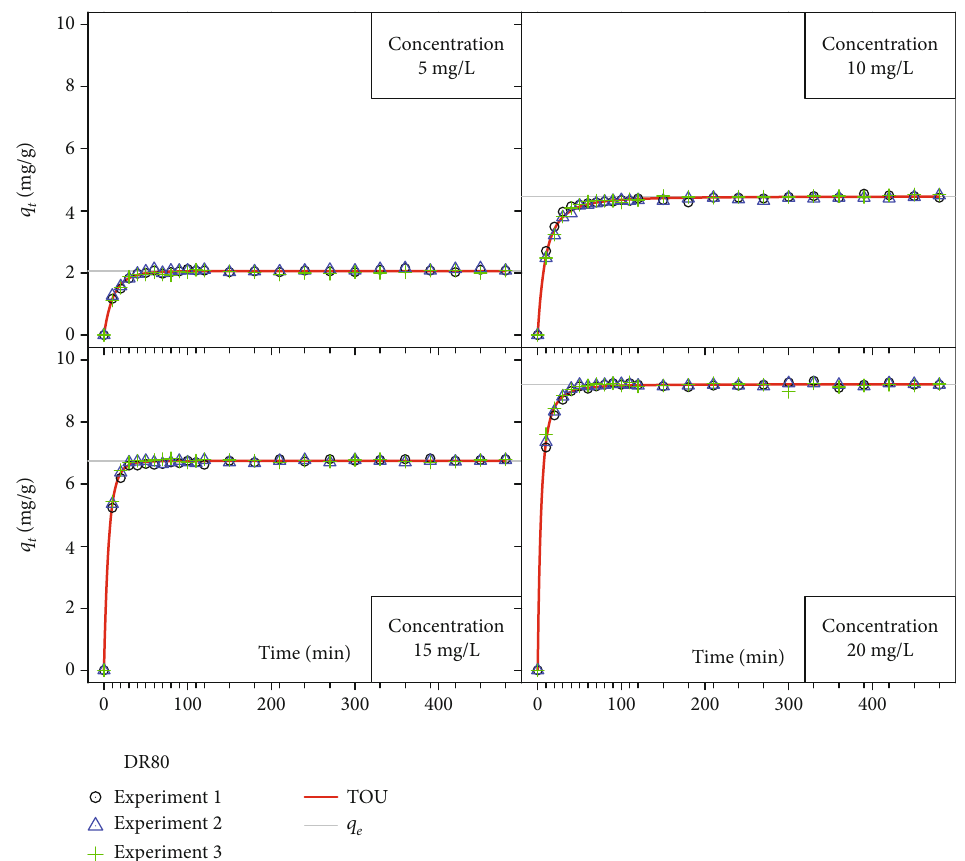
Figure 3: Experimental adsorption kinetics of DR80 dye removal by Pec-Ca for di ff erent dye concentrations and theoretical curves obtained by applying the TOU model to the experimental